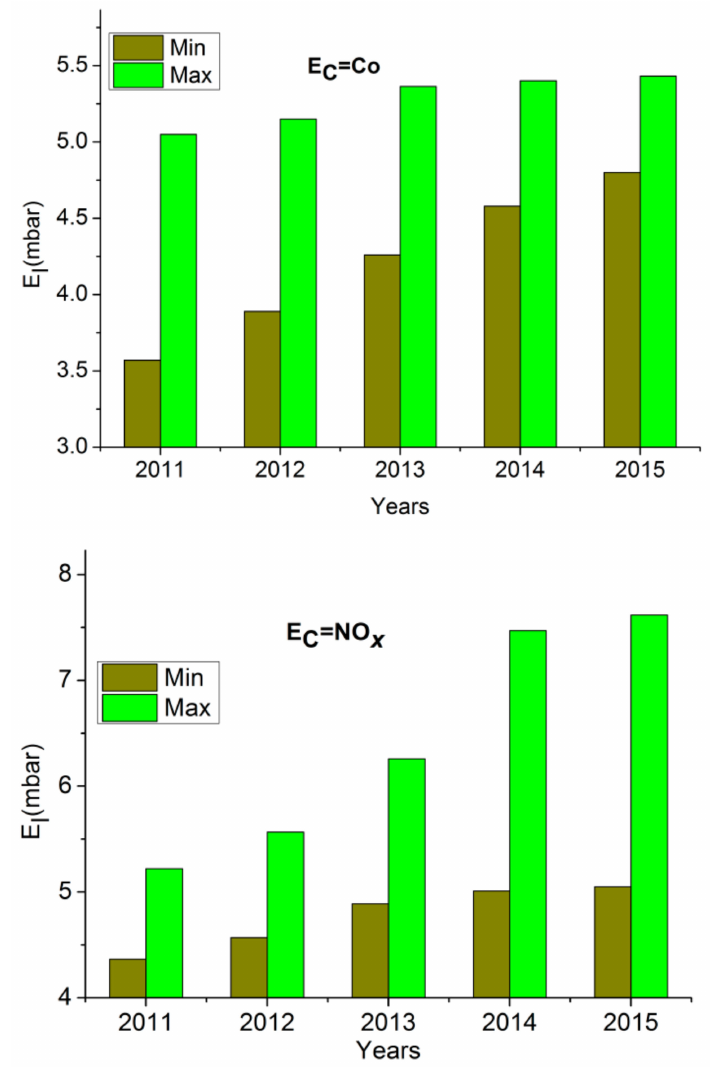
Figure 7. Emission Intensity E I for Carbon Monoxide Co and Nitric Oxide NO x . The variables considered in Figure 5 are used for identifying the min and max intensi- ties. Compared with E R , the E x increases the variation when E R is higher (uneven/less) when compared with the previous years. Therefore, as the years increase, the production increases as the E R and E I for E C = C O and NO X . The E imp for the different years (2011 to 2015) of Co and NO X is presented in Table